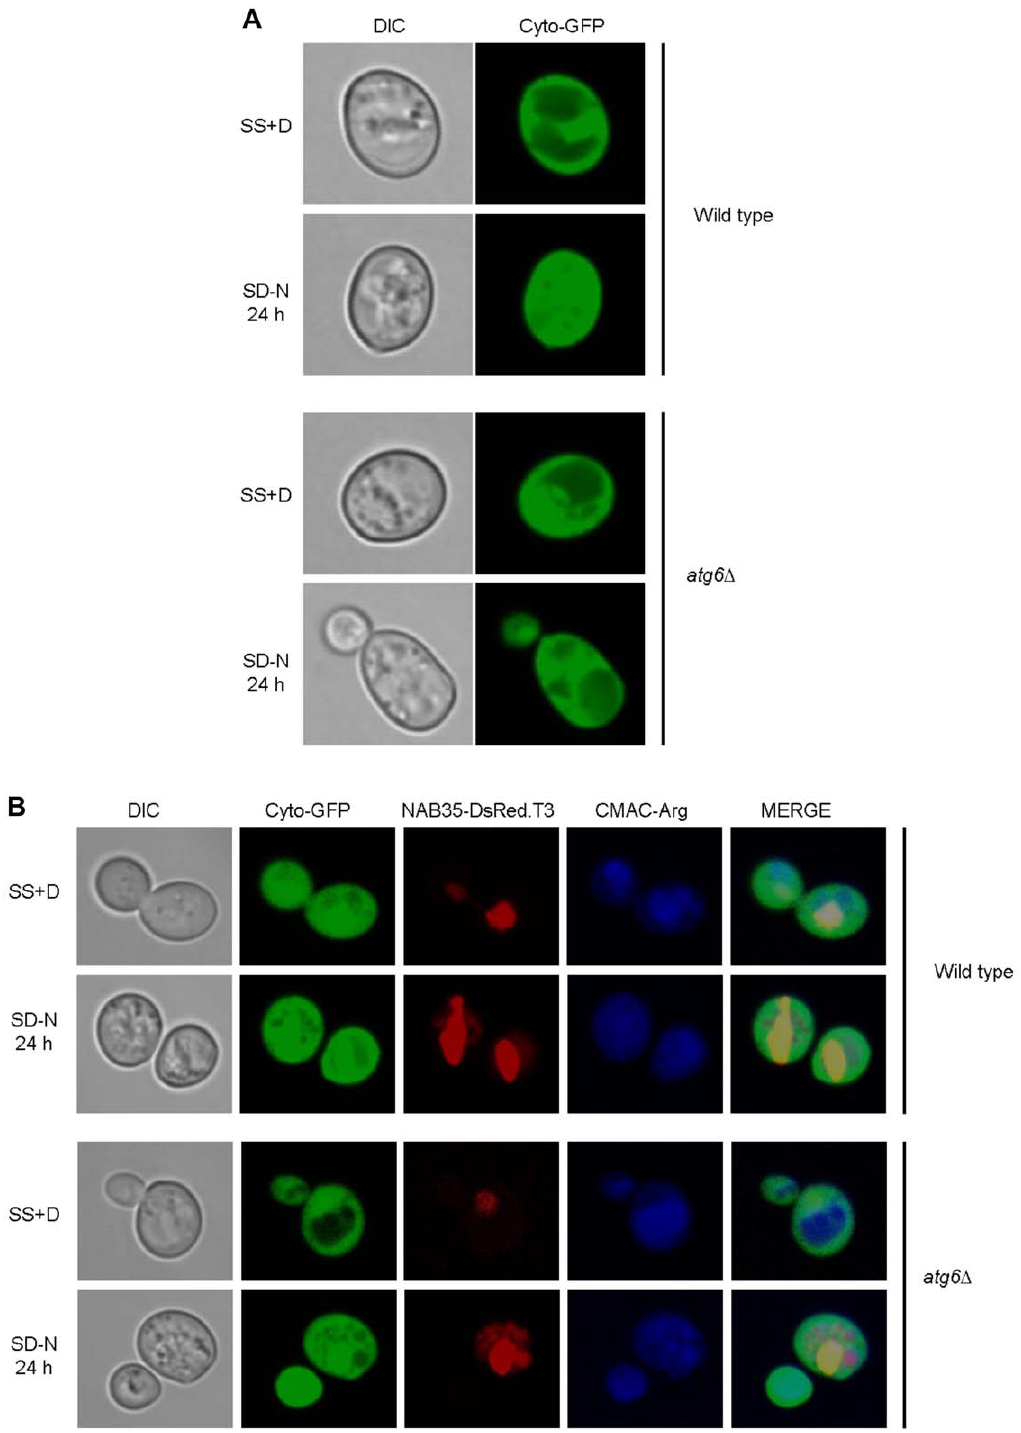
Figure 2. The diffuse red fluorescence (NAB35-DsRed.T3) accumulated in the vacuole is delivered directly from the nucleus. Wild type (BY4741) and atg6 D cells expressing cyto-GFP alone ( A ), or co-expressing cyto-GFP and NAB35-DsRed.T3 ( B ), under growing (SS + D) and nitrogen starvation conditions (SD-N) were sampled after 24 hours. Staining with the vacuolar lumen staining dye, CMAC-Arg was used to confirm delivery of fluorescent reporters to the vacuole. doi:10.1371/journal.pone.0040013.g002 PMN vesicles (Fig. 3A; white arrows and Fig. S1A) could be detected as diffuse red fluorescence only after 20–24 hours detected in the vacuole as early as after 3 hours of nitrogen (Fig. 3A; yellow arrows). A time course of detection of both events starvation, whereas delivery of NAB35-DsRed.T3 could be is presented in Fig. 3B. Notably, vesicles labeled with both Nvj1p-